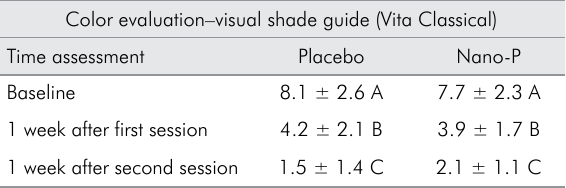
Table. Means (SD) of shade guide units at different times for experimental groups